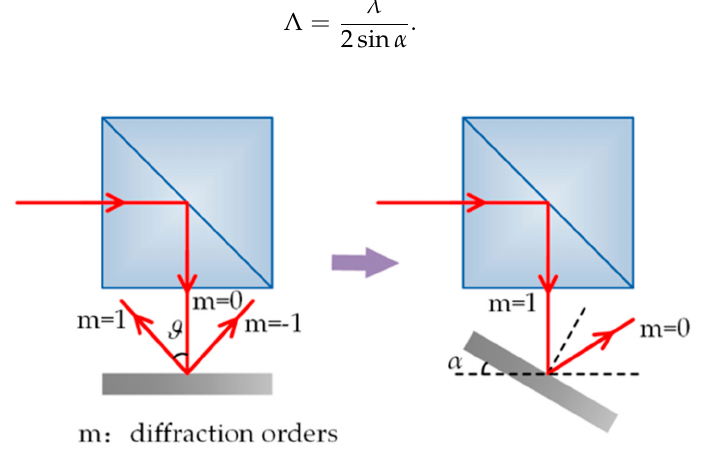
Figure 3. Littrow configuration for grating pitch